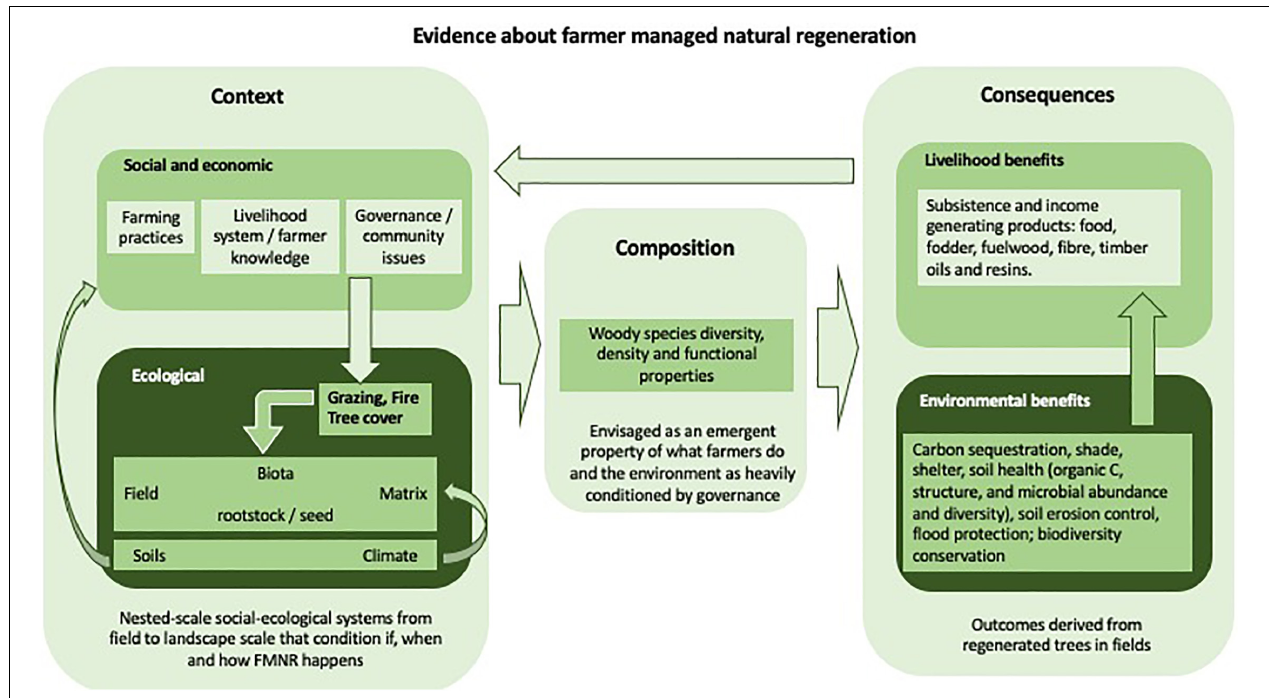
FIGURE 1 | Analytical framework for the assessment of evidence on